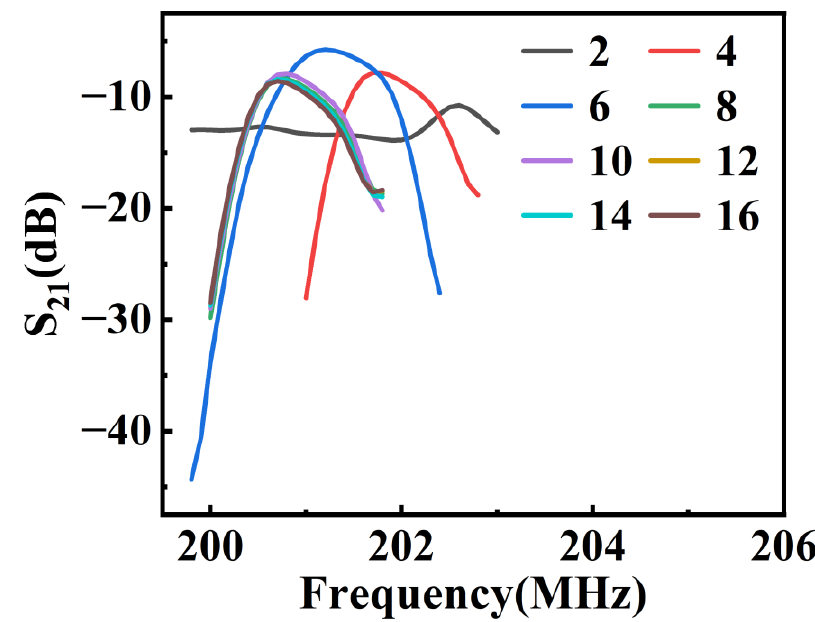
Figure 4. Frequency domain simulation with different num (number of meshes in each wavelength).